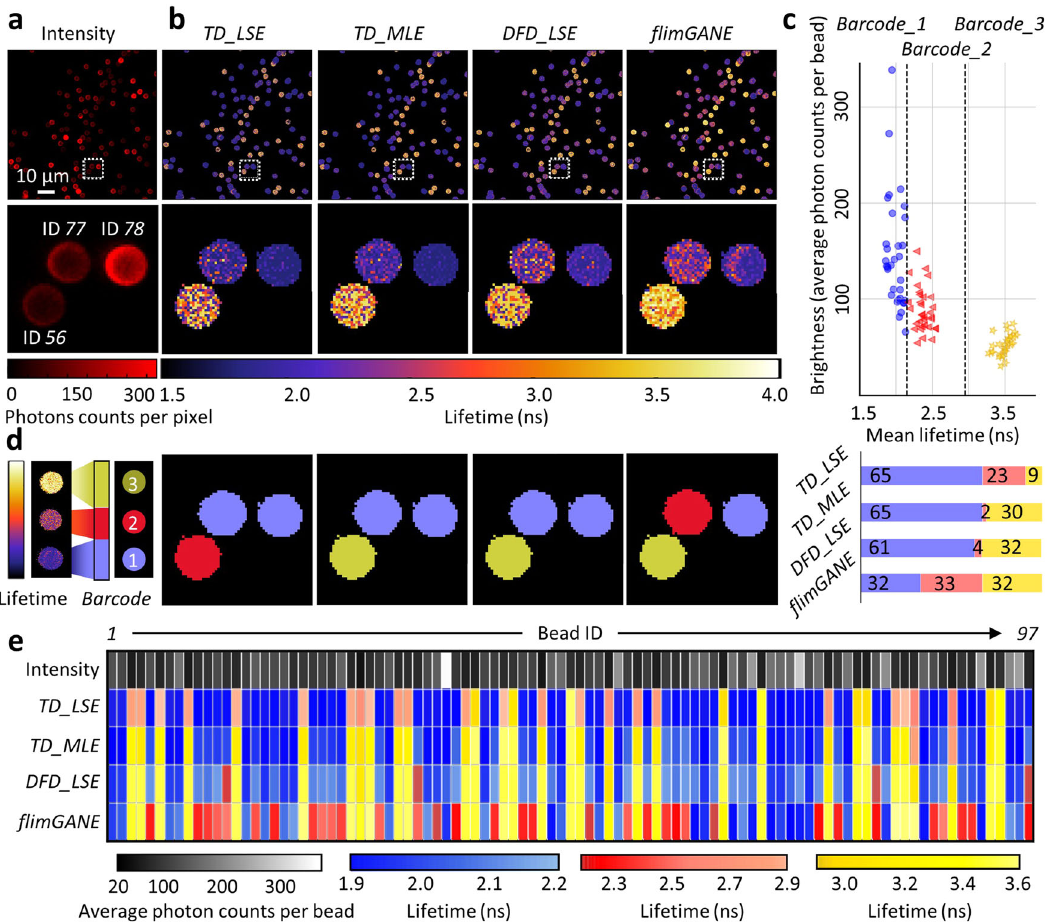
Fig. 2 fl imGANE accurately classi fi es the three fl uorescence lifetime barcode beads. a Intensity contrast images show 3- µ m fl uorescent beads with various brightness. b FLIM images obtained from TD_LSE , TD_MLE , DFD_LSE , and fl imGANE discriminate fl uorescence lifetime barcode beads. c Mean lifetimes versus brightness plot of 97 beads shows the intensity differences of the three barcodes and the cutoff lifetimes (2.15 and 2.95 ns) for barcode identi fi cation. d Barcode classi fi cation results by the four methods indicate that only fl imGANE can correctly identify the three barcodes and restore the correct barcode ratio (1:1:1). e Classi fi cation results of all 97 beads show that many barcode_2 beads are misidenti fi ed as barcode_1 beads by TD_LSE , TD_MLE, and DFD_LSE , while the identi fi cation of barcode_3 beads is more reliable among these methods (except for TD_LSE , which performs poorly under the low-light